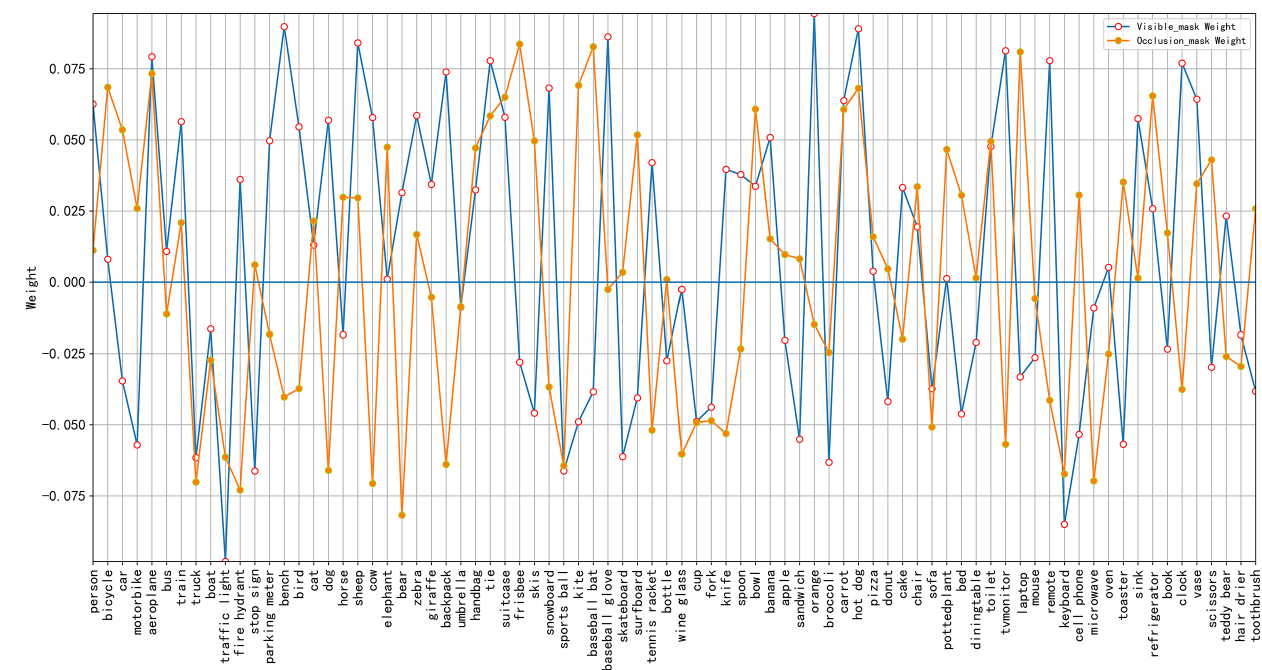
Figure 5. This is the plot of the cat’s 1 × 1 conv weight. The abscissa represents the category of the instance in the dataset. The ordinate is the weight